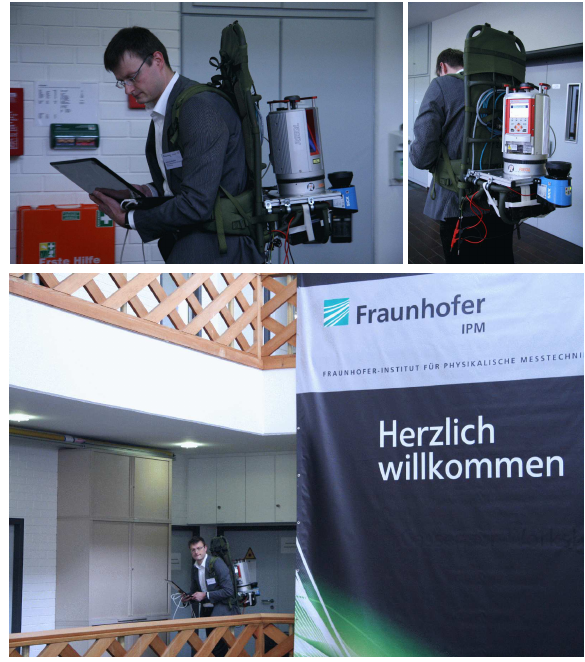
Figure 1. Photos of the first author operating the backpack system at MoLAS, in Freiburg, November